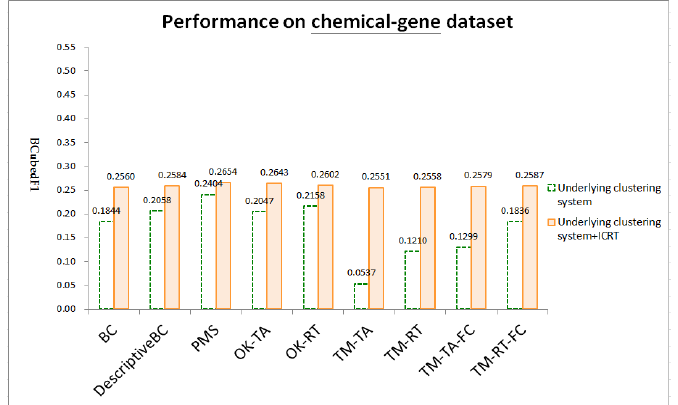
Figure 4. Test results on the chemical-gene dataset.